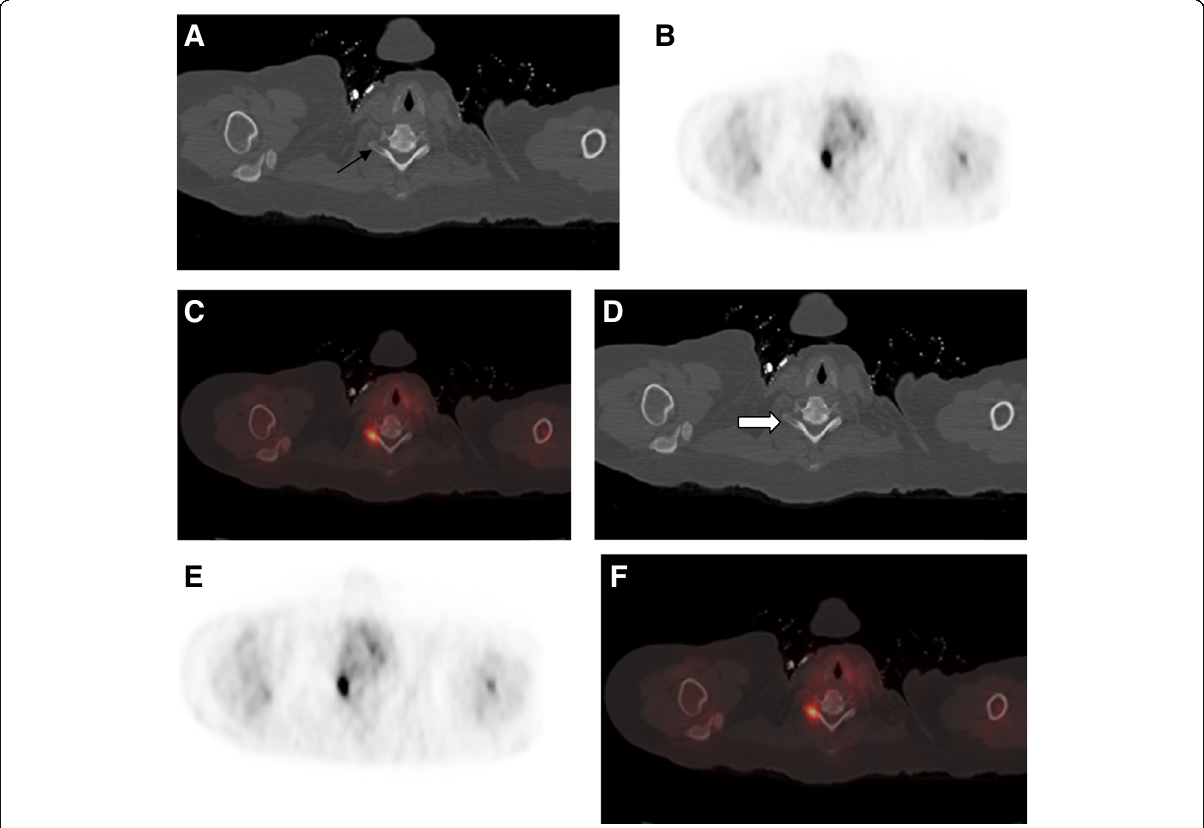
Fig. 4 Follow up post chemotherapy regimen for patient with history of breast cancer. a Axial CT bone window showing isolated lytic ossoeus lesion targeting CV7 right pedicle. b Correponding PET axial image. c Corresponding PET/CT fused image showing avid uptake within the lesion by visual assessment method, SUV max: 7. d Axial CT bone window 6 months post chemotherapy regimen. e Corresponding PET axial image and f fused PET/CT image showing no appreciable interval changes. Non